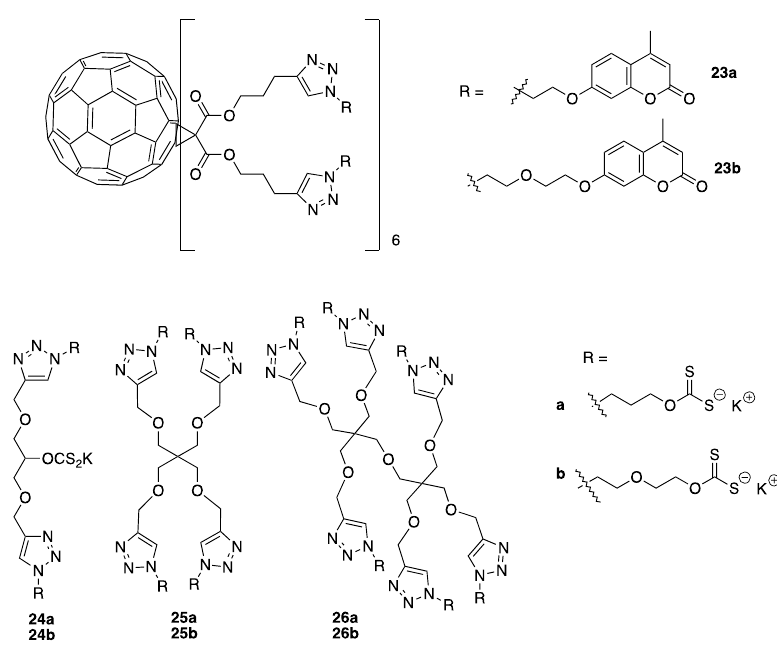
Figure 5. Multimeric systems described by Vincent et al. [27,28].